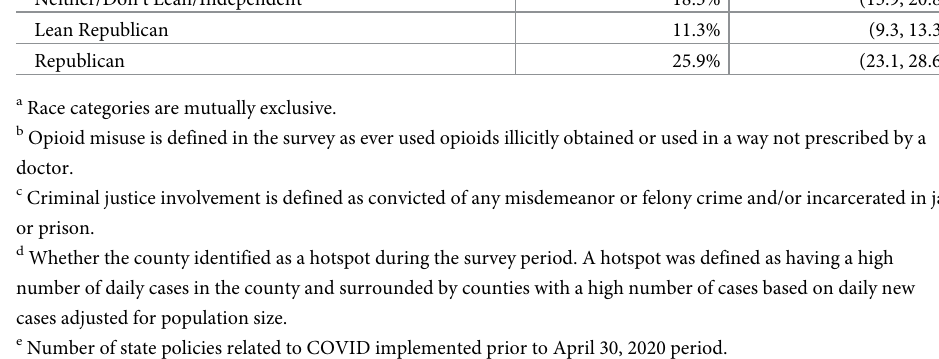
PLOS ONE | https://doi.org/10.1371/journal.pone.0259257 November5,